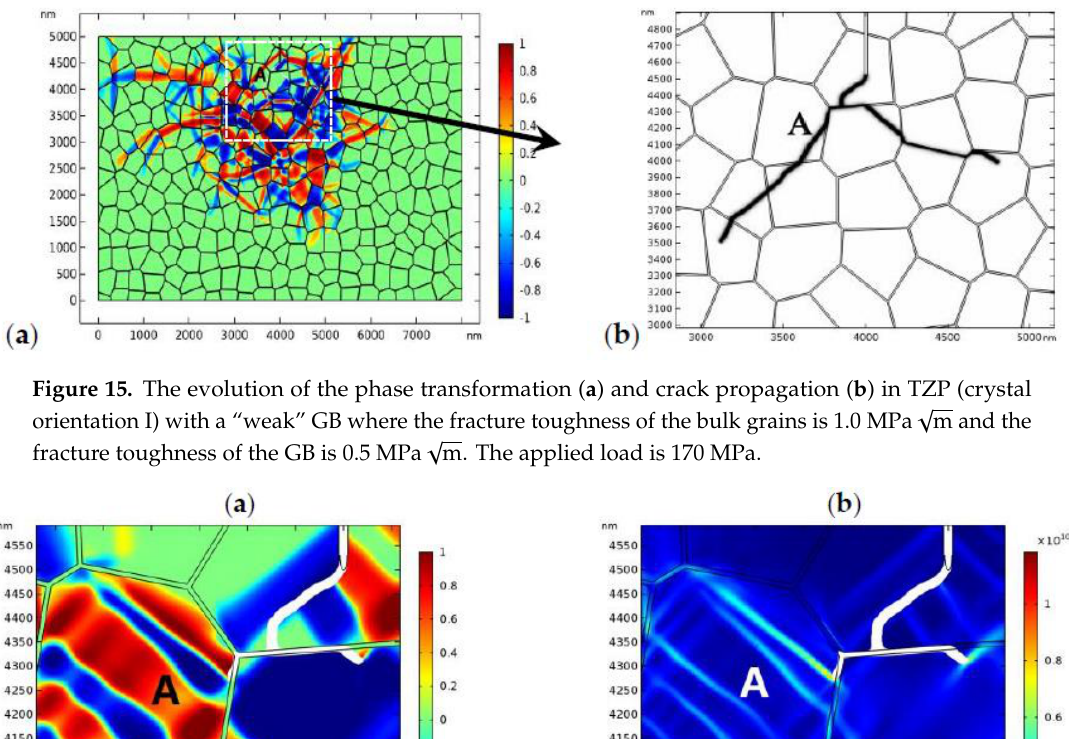
Figure 14. The evolution of the phase transformation and crack propagation in TZP (crystal orientation II) with a “weak” GB (plots represent η 1 − η 2 , and the crack is displayed in the amplified window separately), where the applied load is 150 MPa: ( a – f ) at times 0.4, 1.0, 1.3, 1.7, 2.0, and 2.5 µ s, respectively.